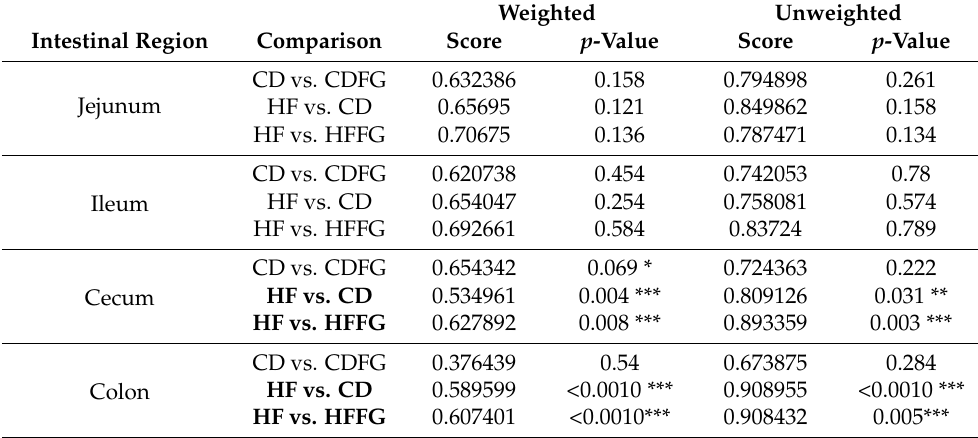
Table 2. Comparison of microbial communities in the intestinal regions of CD- or HF-fed mice each with and without fenugreek supplementation. Comparisons were made using both weighted and unweighted Unifrac phylogenetic analysis metrics. Significance is indicated as * p < 0.1, ** p < 0.05, *** p <